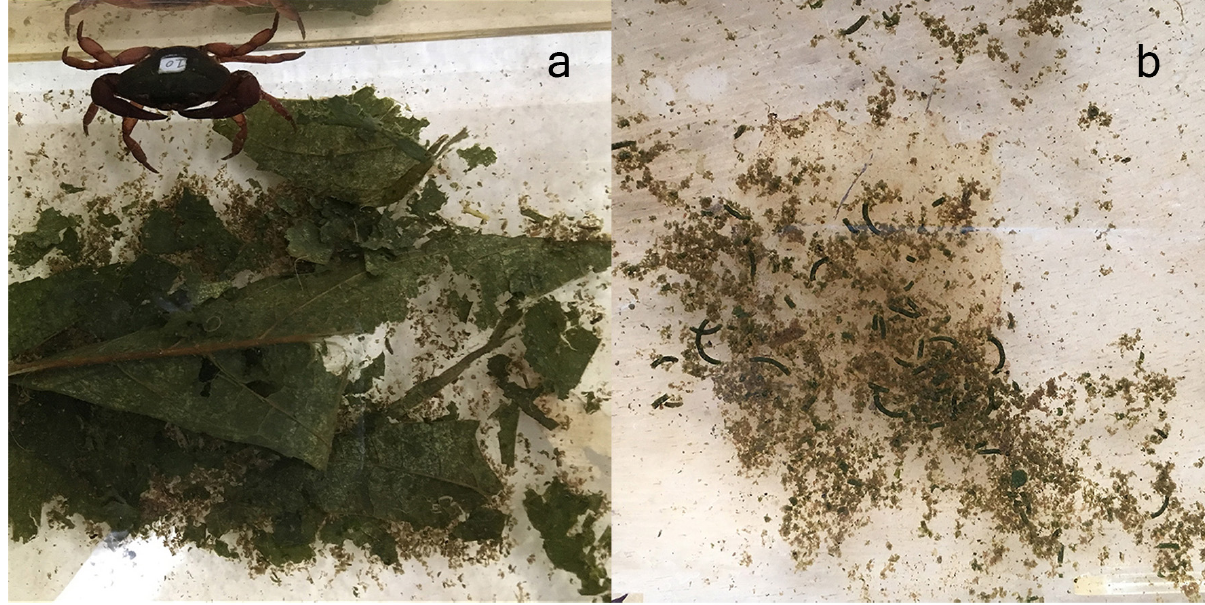
Figure 4. Tank with crabs ( Ptychophallus tumimanus ) after nine days: A , Crab with remaining leaf mass in tank; B , Crab egesta in tank.